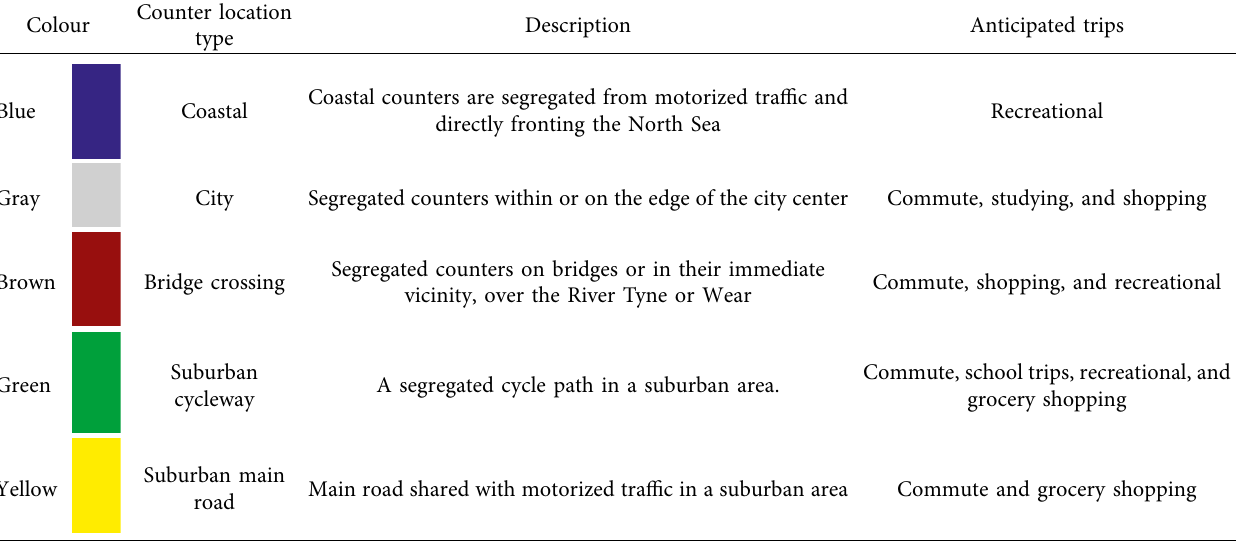
Table 1: Cycling induction loop counter location